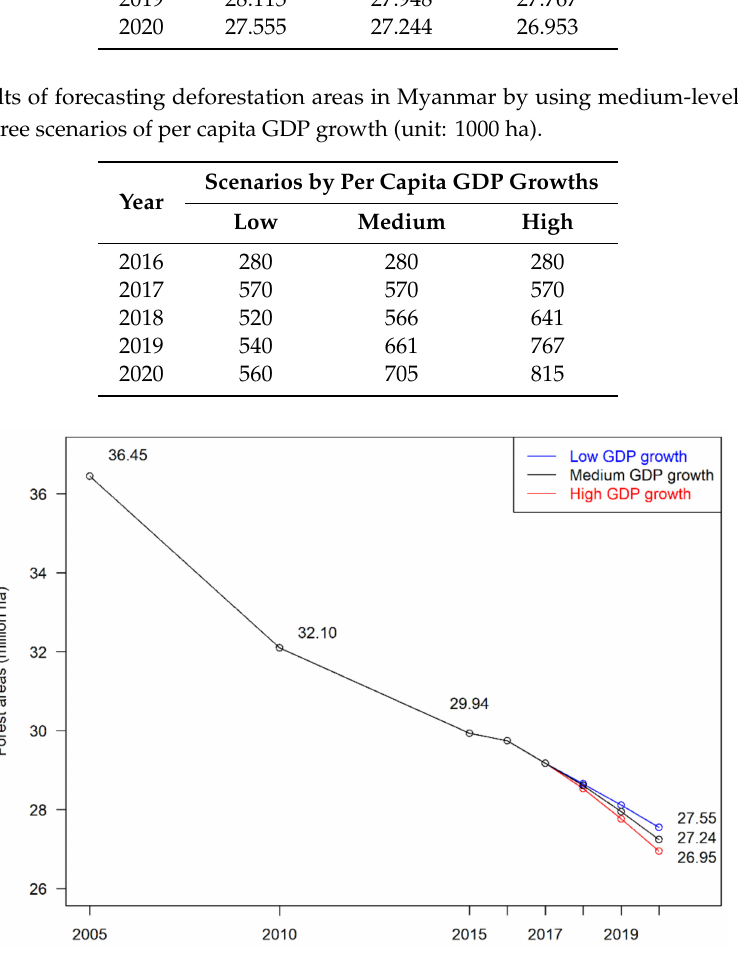
Figure 5. Forecasts of three GDP